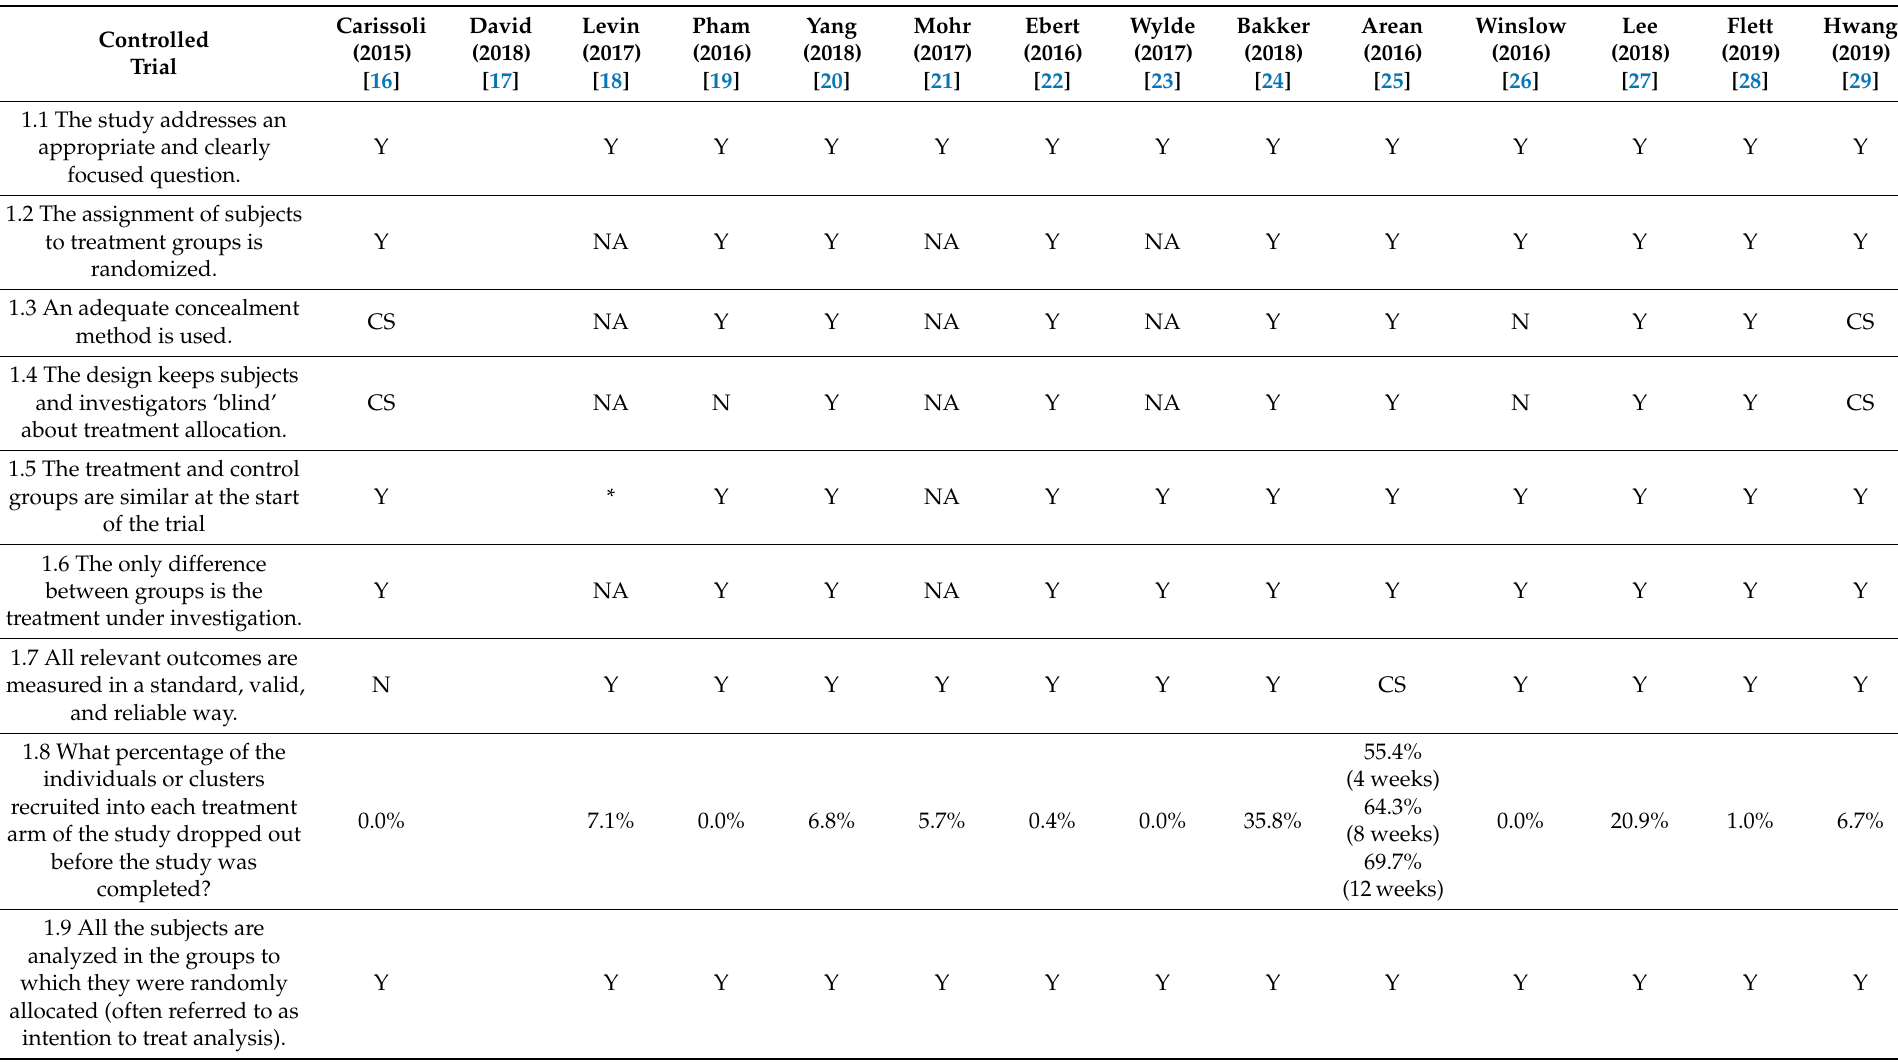
Table 2. Quality evaluation of the selected